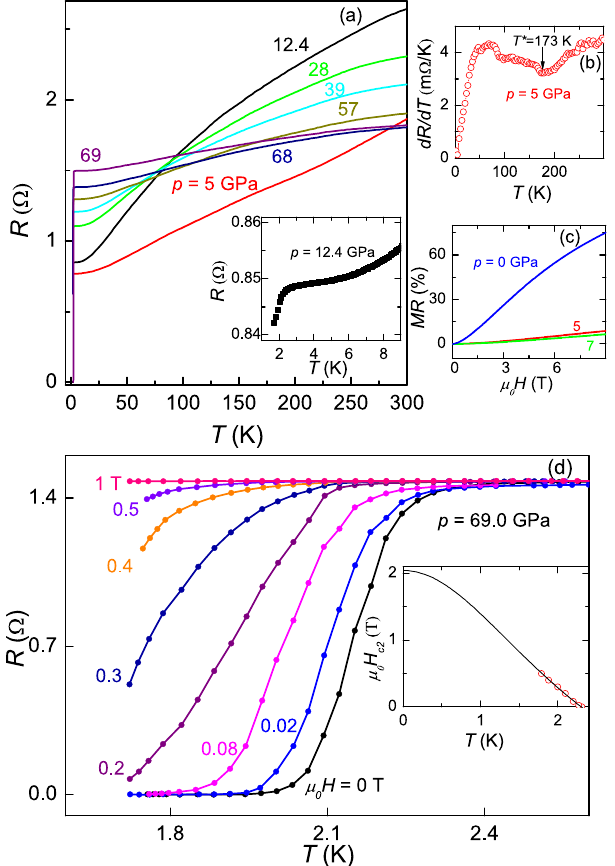
Figure 4. Transport properties for single crystal NbTe 4 under pressure. (a) The plot of resistance versus temperature for the pressure ranging from 5 GPa to 69 GPa. The current is along the c -axis. The inset: The enlarged plot of resistance at low temperatures under p = 12.4 GPa. (b) Plots of d R /d T versus temperature under p = 5 GPa. (c) Field dependence of MR under p = 0, 5 and 7 GPa. (d) Temperature dependence of resistance for several different magnetic fields under p = 69 GPa. The inset displays the upper critical fields as a function of